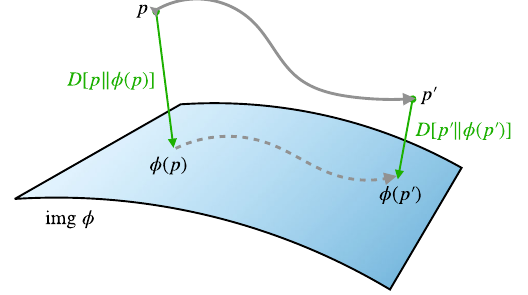
FIG. 3. Illustration of Theorem 2. Given an appropriate operator ϕ , Σ ð p → p 0 Þ (the EP incurred during some desired transformation p → p 0 ; solid gray line) is equal to Σ ½ ϕ ð p Þ → ϕ ð p 0 Þ(cid:2) [the EP incurred by that protocol when transforming ϕ ð p Þ → ϕ ð p 0 Þ ; dashed gray line] plus the contraction of the KL divergence D ½ p k ϕ ð p Þ(cid:2) − D ½ p 0 k ϕ ð p 0 Þ(cid:2) (contraction of green lines). This contraction of KL divergence is a non-negative lower bound on Σ ð p → p 0 Þ , as in Eq.